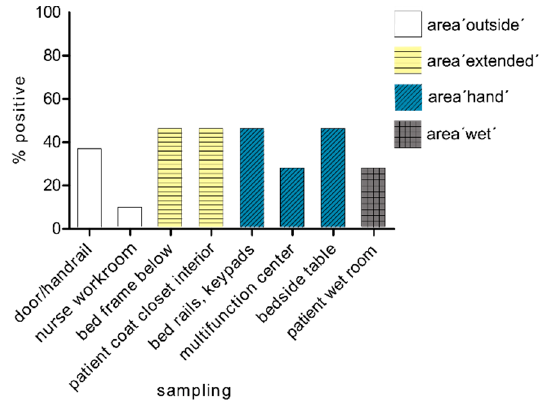
Figure 4. Spread after one week. Spread of carbapenemase-positive organisms within the four tested areas after one week hospitalisation of the patient in the room ( n = 11).